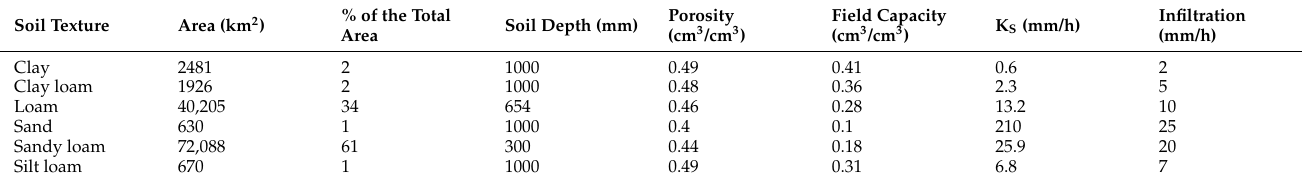
Table 2. Soil properties in the source region of the Yellow